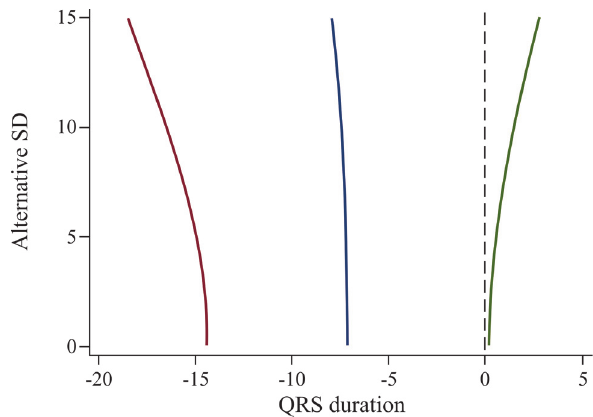
Figure 1 - Summary results under alternative values for the standard devi- ation for the study by Hughes et al. (2008). The blue line depicts the sum- mary,unstandardizedmeandifference,whereasredandgreenlinesdenote lower and upper 95% confidence limits, respectively. Dashed line repre- sents the null effect. Results are based on a random effects model.